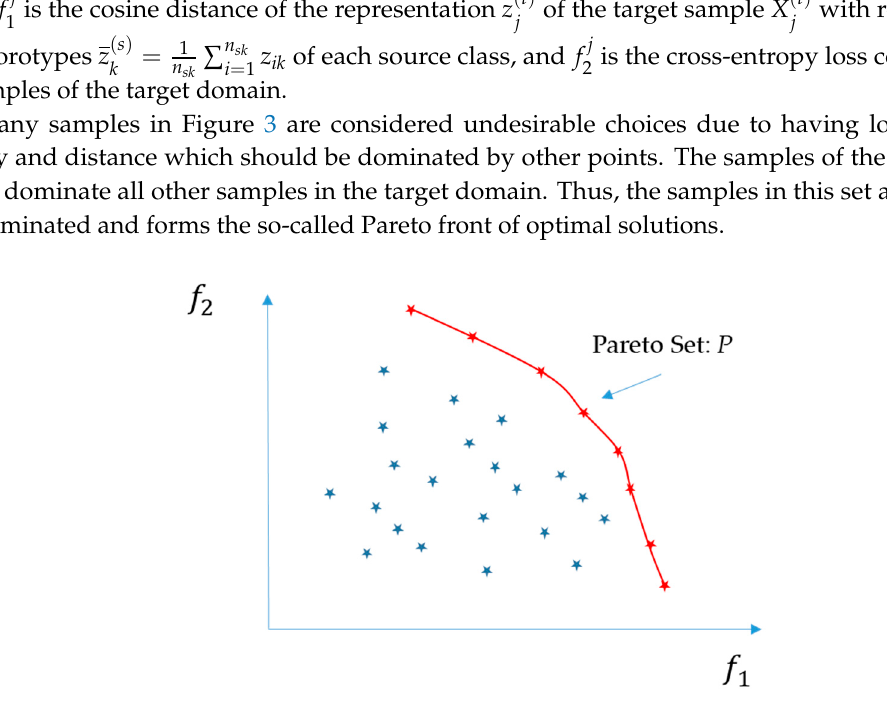
Figure 3. Pareto-front samples potentially indicating the presence of the unknown class.